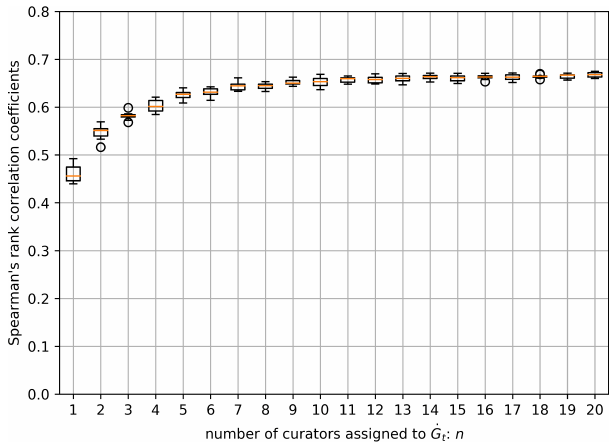
Fig. 4. The first experiment computes Spearman’s rank correlation coefficients between the frequency distribution of curator assignment up to G 1000 and the PageRank score to the DAG in G 1000 . The box plot for all 200 coefficients (10 times for each n = { 1 , 2 , ··· , 20 } ) represents the moderate positive correlation, which increases as n increases and converges between 0 . 65 and 0 . 7. This result supports our assumption that CitedTCR tends to select curators more frequently from nodes that are considered important in G t .